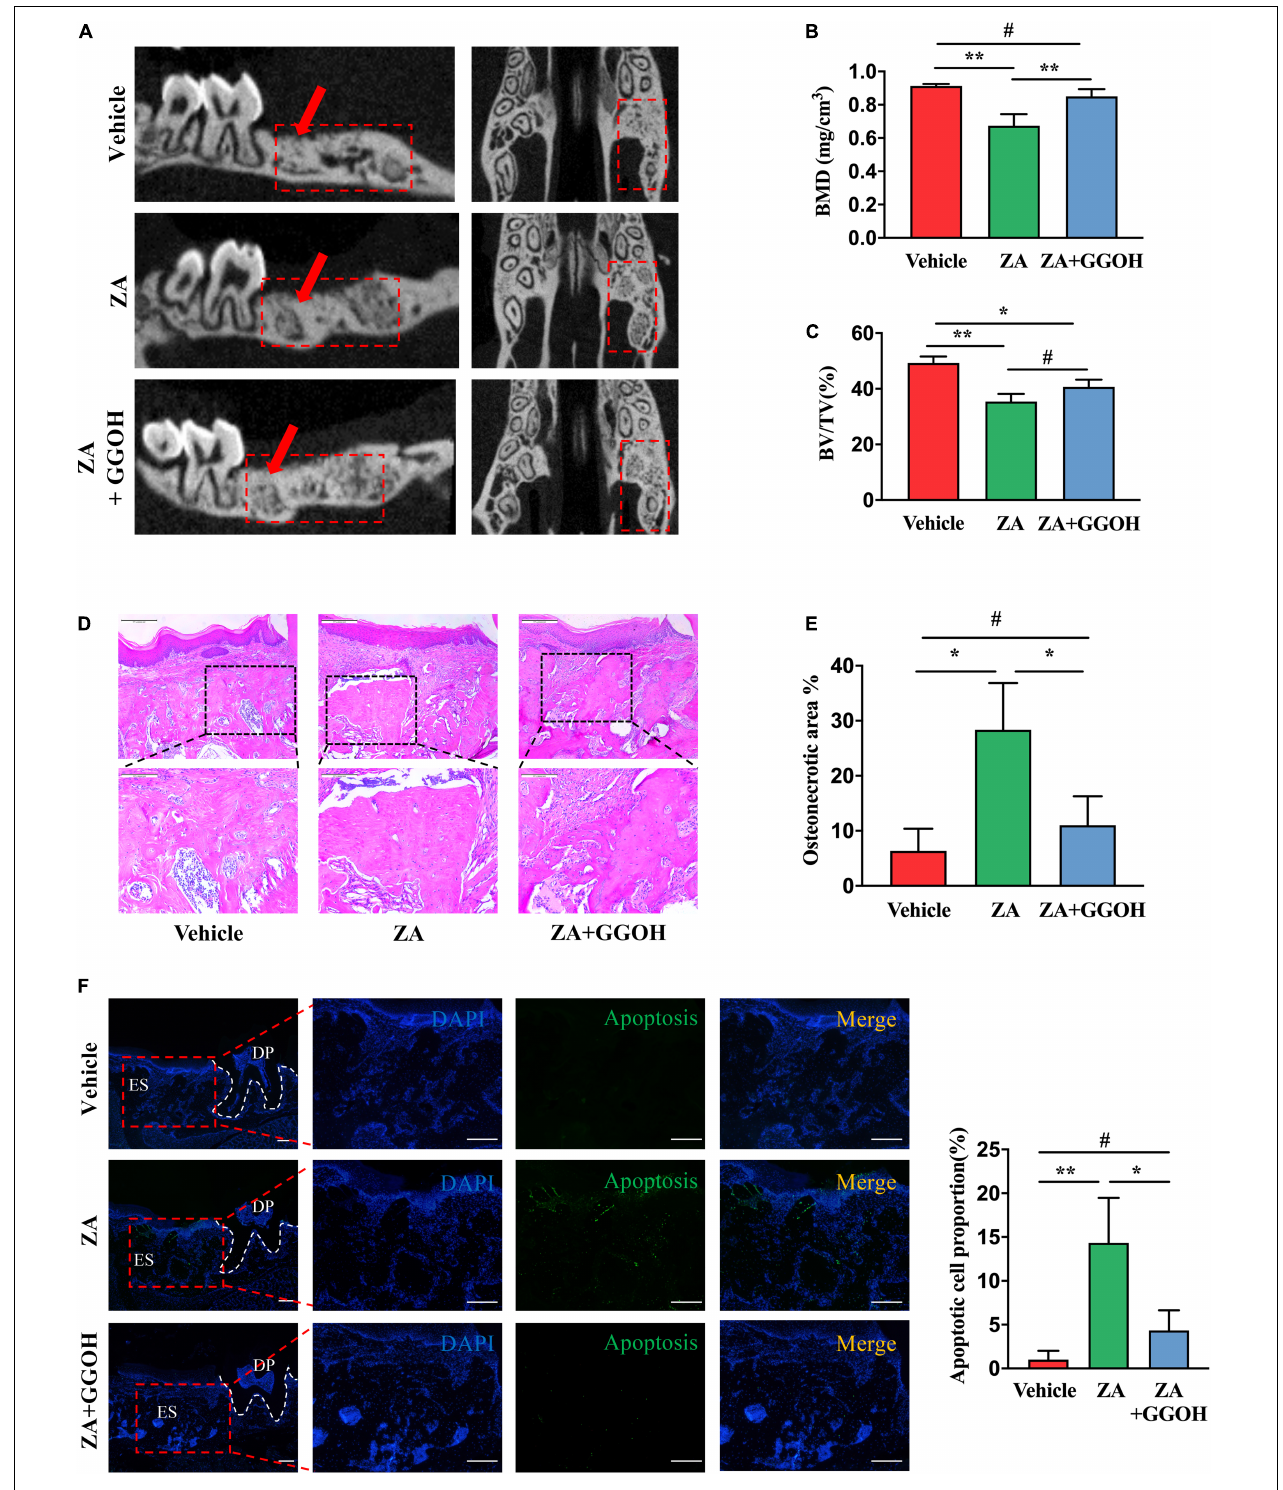
FIGURE 4 | GGOH prevents the development of BRONJ. (A–C) Micro-CT analysis of the first molar distal buccal root was performed. (D,E) H&E staining of the extraction socket 4 weeks after tooth extraction. Scale bar, 500 µ m. (F) TUNEL staining the extraction socket 4 weeks after tooth extraction. Scale bar, 100 µ m. ES, extraction socket; DP, dental pulp. The data are presented as the mean ± SEM values ( n = 3). * p < 0.05, ** p < 0.01, # p > 0.05. GGOH, geranylgeraniol; BRONJ, bisphosphonate-related osteonecrosis of the jaw.